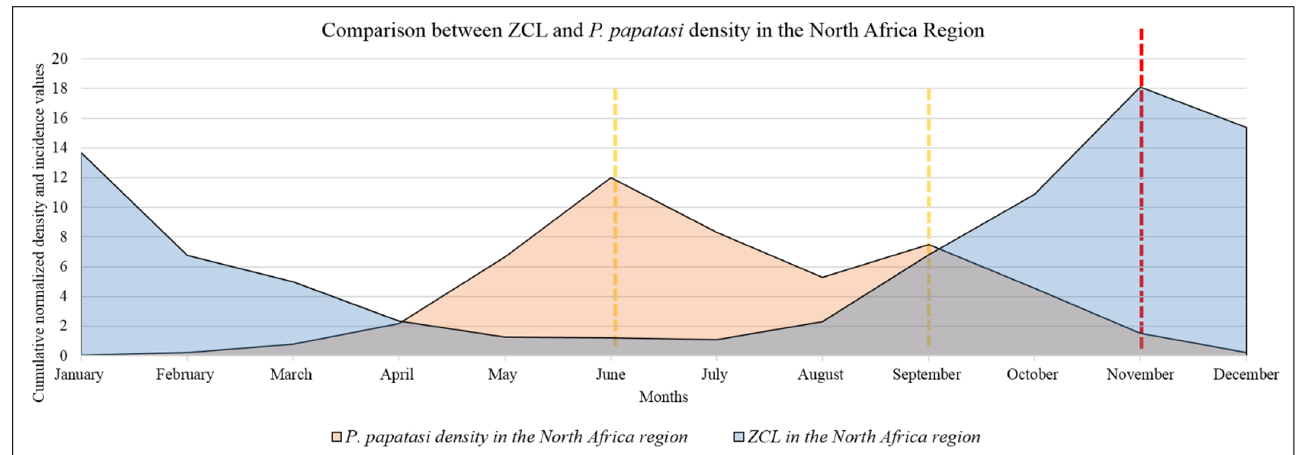
Figure 6. Seasonality of ZCL cases and P. papatasi sand fly vector density in the studied countries. Data were expressed as a cumulative normalized density value of stations under study.